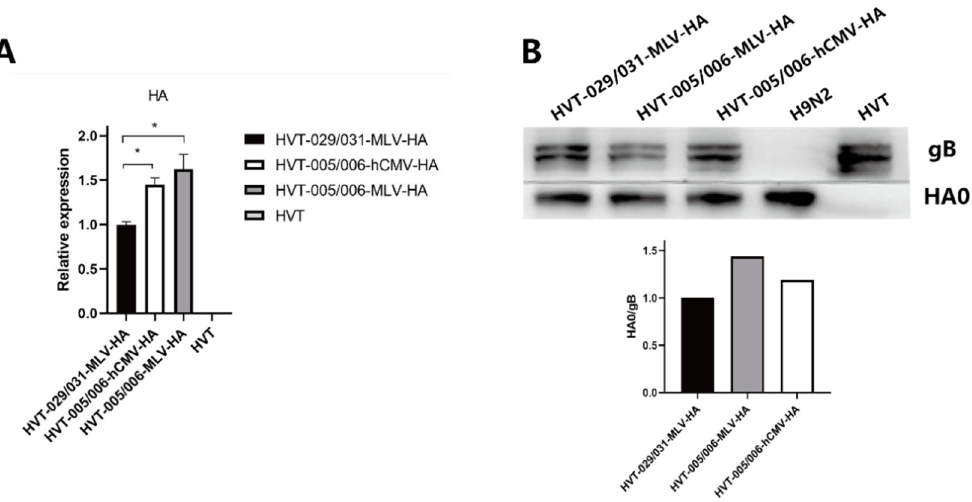
Figure 3. ( A ) Relative expression levels of HA mRNAs in CEF cells infected with HVT or recombi- nant HVT viruses. Asterisks (*) indicate a statistically significant difference. *, p < 0.05. ( B ) Detection of HA protein expression by western blot and grayscale analysis by western blot.